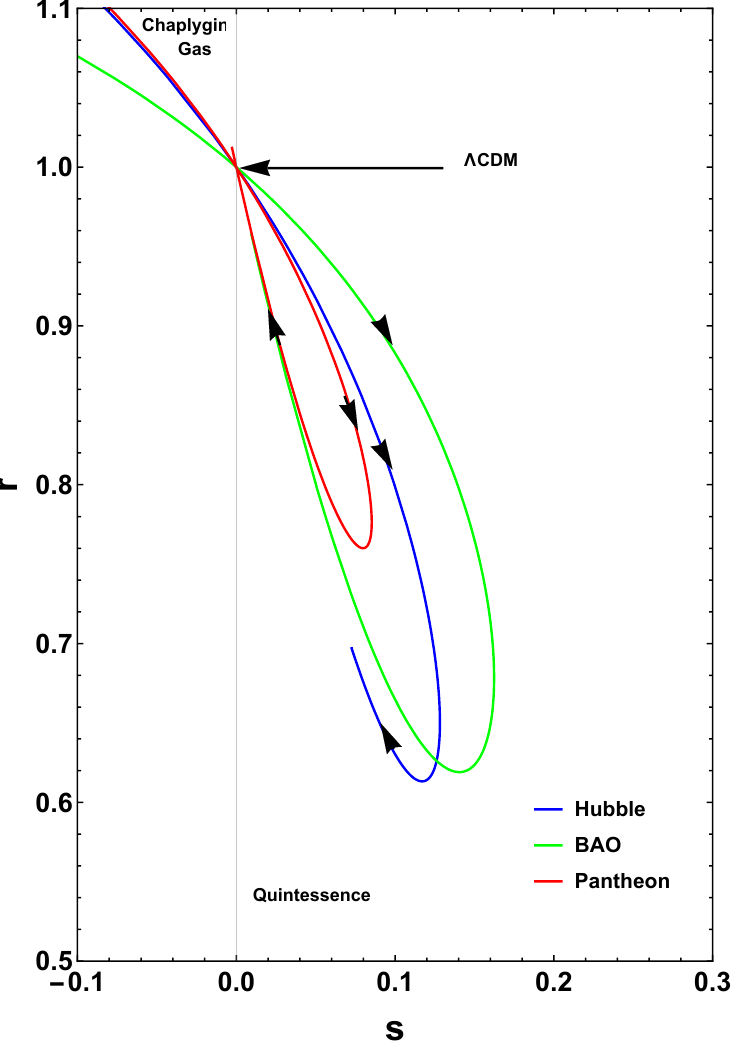
Figure 12. Plot of the trajectories in the r − s plane for the given cosmological model corresponding to the parameter values constrained by the Hubble, BAO, and Pantheon